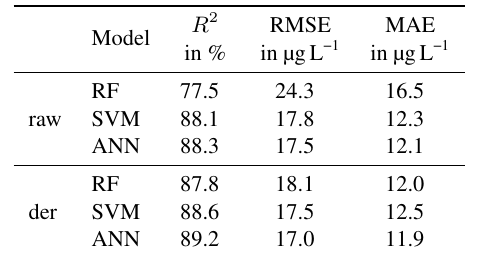
Table 4. Regression results for chlorophyll a estimation with 8nm spectral resolution for the raw dataset (raw) and the dataset with derivatives (der).